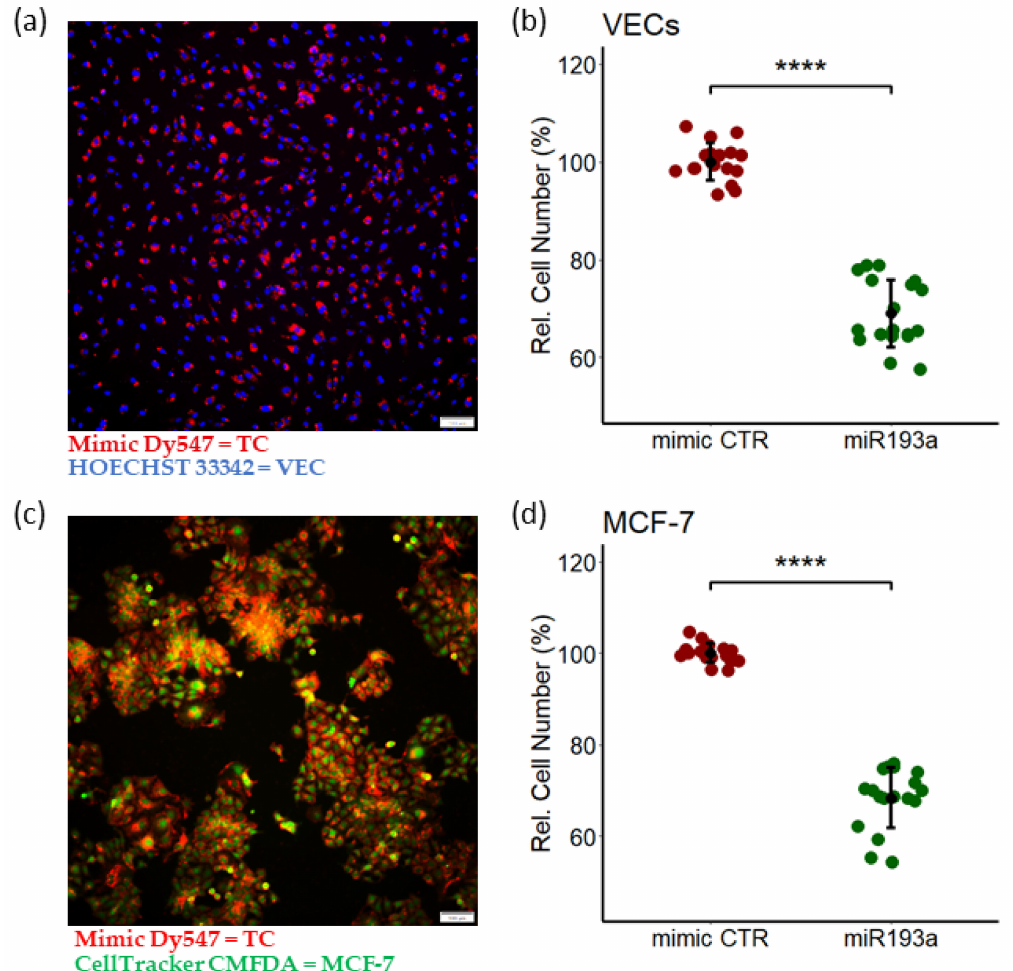
Figure 2. miR193a overexpression inhibits VEC and MCF-7 cell growth. Representative photomicro- graphs showing transfection efficiency of miR193a in VECs ( a ) and MCF-7 cells ( c ). Photomicrograph depicts fluorescence microscopy image of VECs transfected with Mimic Dy547. Red: Mimic Dy547; blue: HOECHST 33342; green: CellTracker Green CMFDA; TC: Transfected cells. Scale bar, 100 µ m. VECs ( b ) and MCF-7 cells ( d ) were transfected with control mimic or miR193a and after 3 days cell proliferation was assessed by cell counting. Experiments were performed at least 3 times in triplicates. p < 0.00001 **** compared to the respective